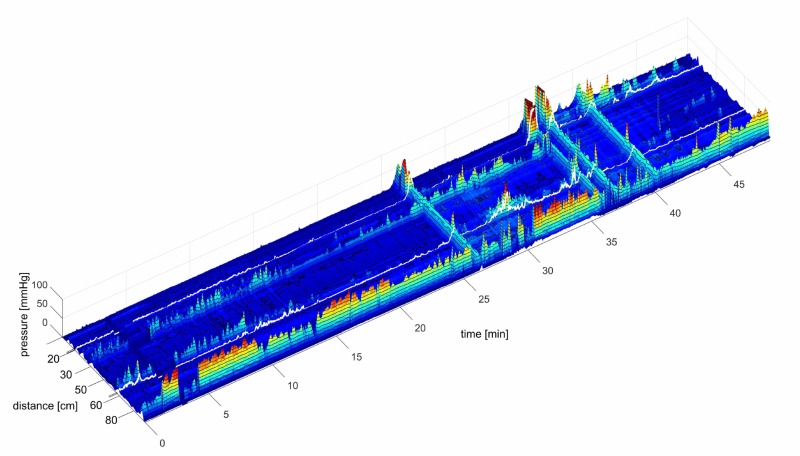
High amplitude SPWs in response to rectal bisacodyl. A 10 mg bisacodyl suspension was injected in the rectum at 16 min. Between 3 and 4 min, data acquisition was halted due to refilling of water reservoirs. This subject produced normal HAPWs in response to balloon distention (not shown). The average amplitude of the SPWs in response to bisacodyl was 32.2 mmHg. All 4 SPWs were associated with liquid outflow and the middle two SPWs with gas expulsion as well.